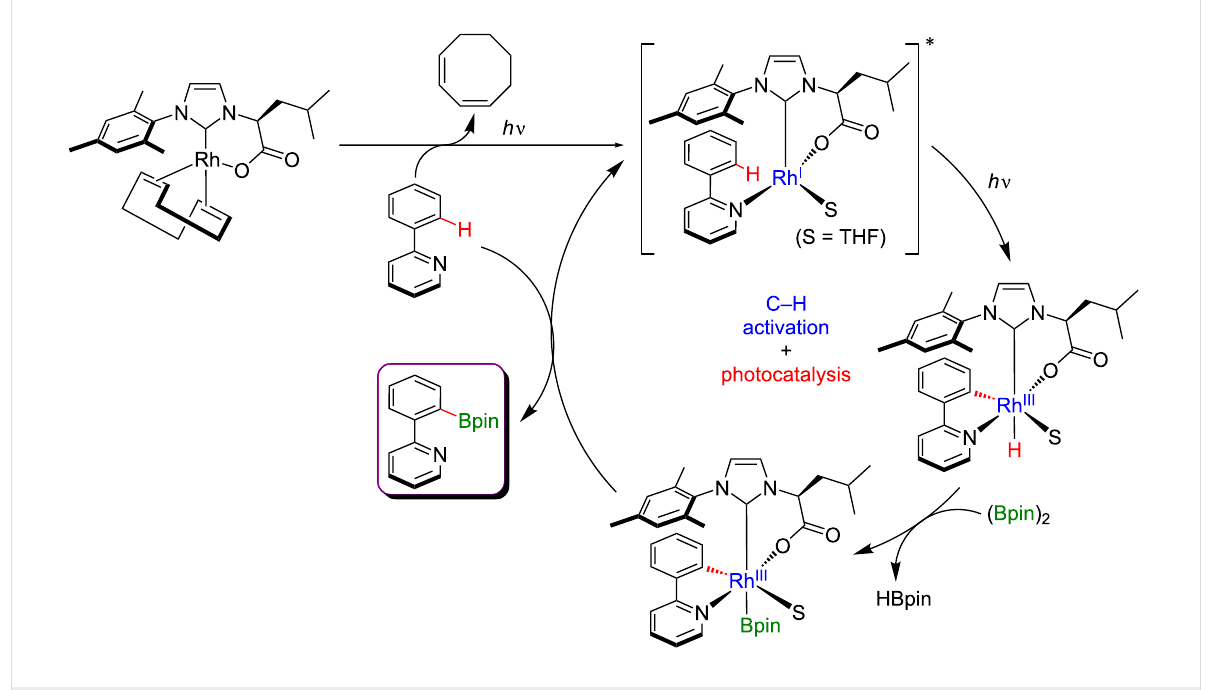
Figure 41: Proposed mechanism for C–H borylation of arenes via visible-light metallaphotocatalysis.